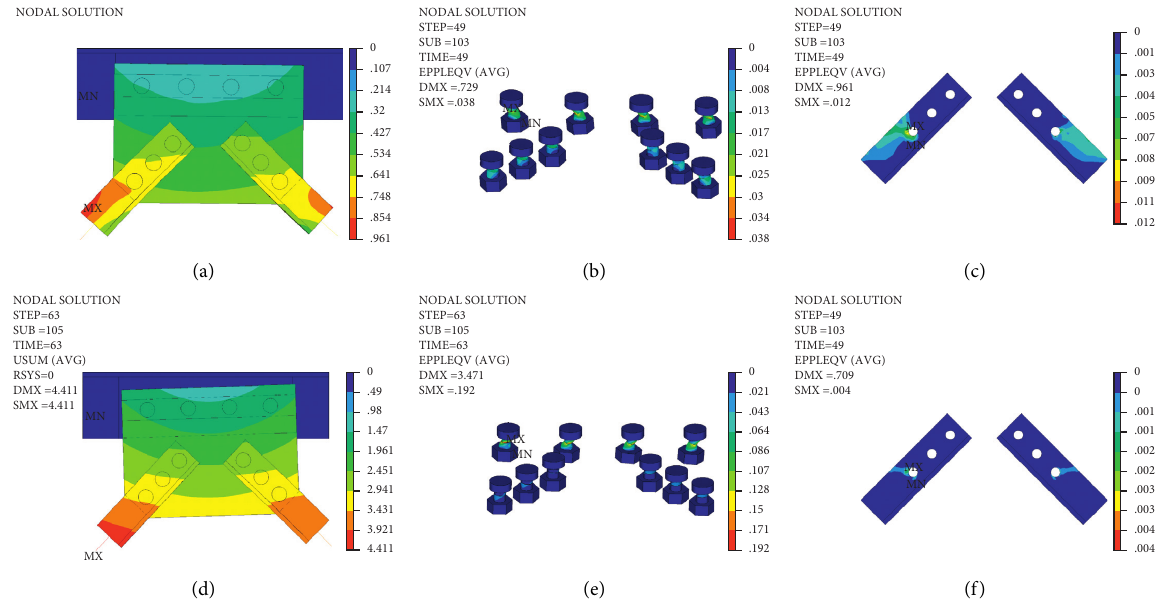
Figure 10: Simulation results for Cases 1 and 7. (a) Displacement of joint in Case 1. (b) Plastic strain of bolts in Case 1. (c) Plastic strain of branch angle steel in Case 1. (d) Displacement of joint in Case 7. (e) Plastic strain of bolts in Case 7. (f) Plastic strain of branch angle steel in Case